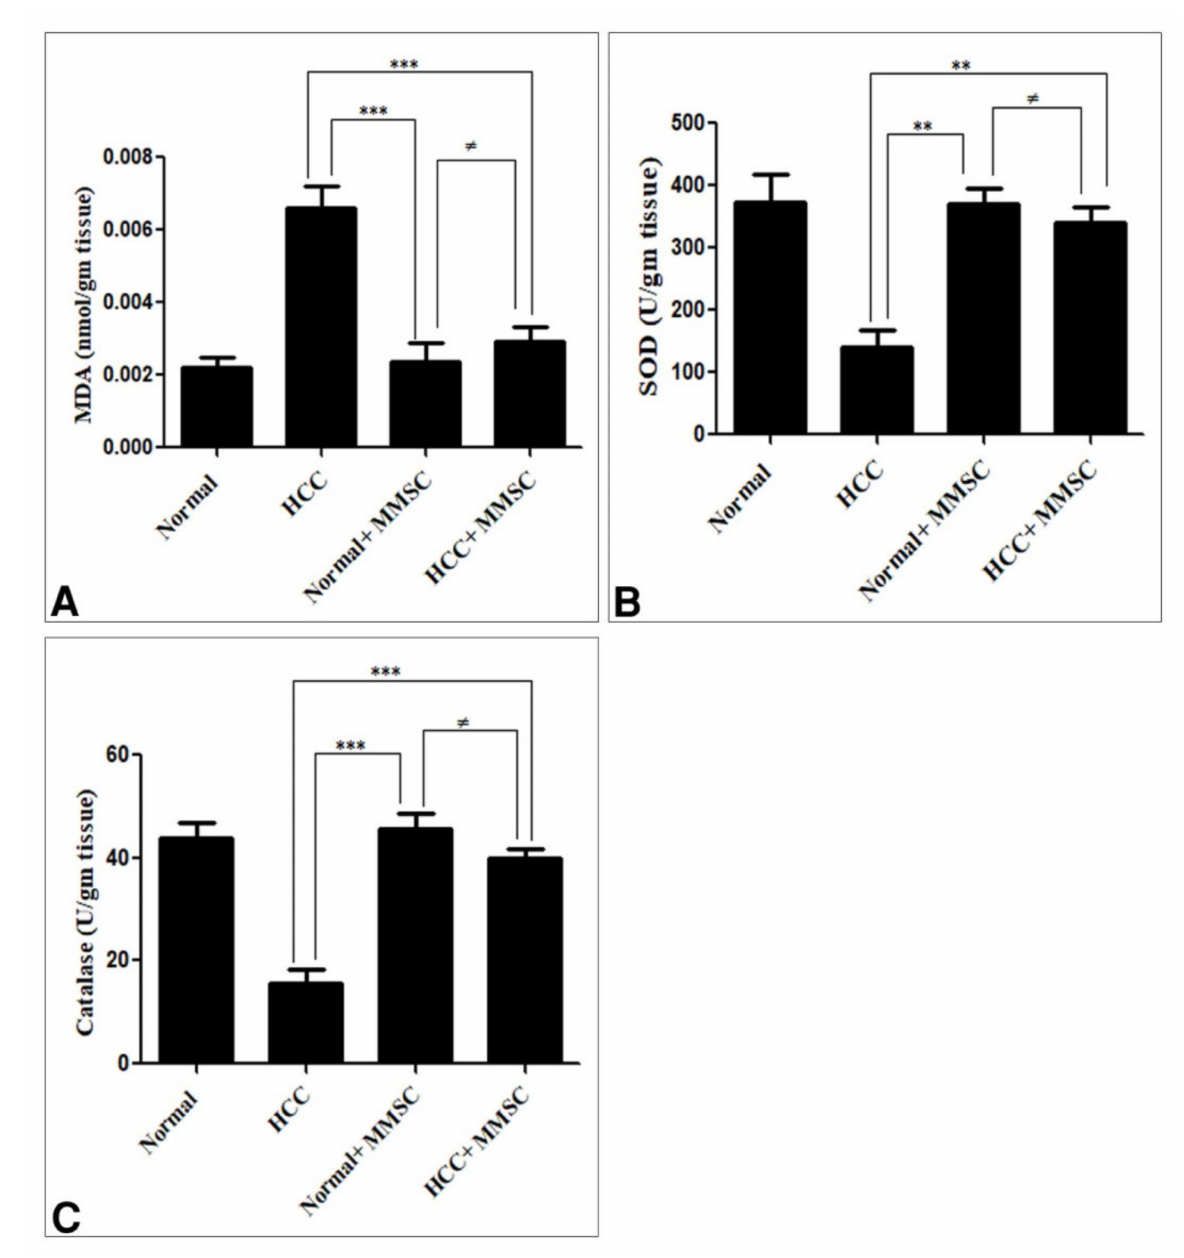
Figure 3. Serum level of ( A ) malondialdehyde (MDA), ( B ) superoxide dismutase (SOD), and ( C ) catalase in all groups. Data were presented as mean ± SEM. ** Significantly different at p < 0.001, *** Significantly different at p < 0.0001, (cid:54) = no significantly difference using ANOVA followed by Bonferroni’s as a post-hoc test. Hepatocellular carcinoma (HCC), S-methylmethionine sulfonium chloride